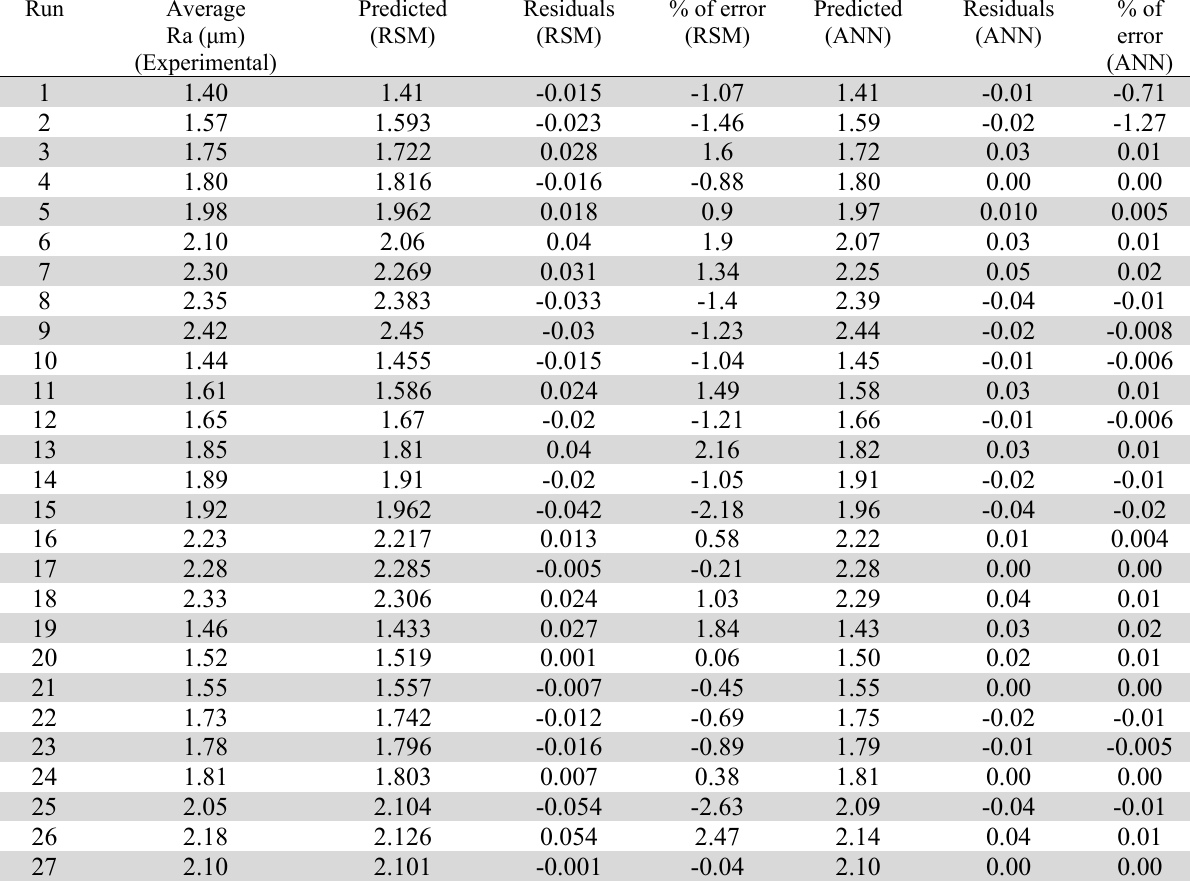
Comparisons of experimental vs. RSM and ANN for surface